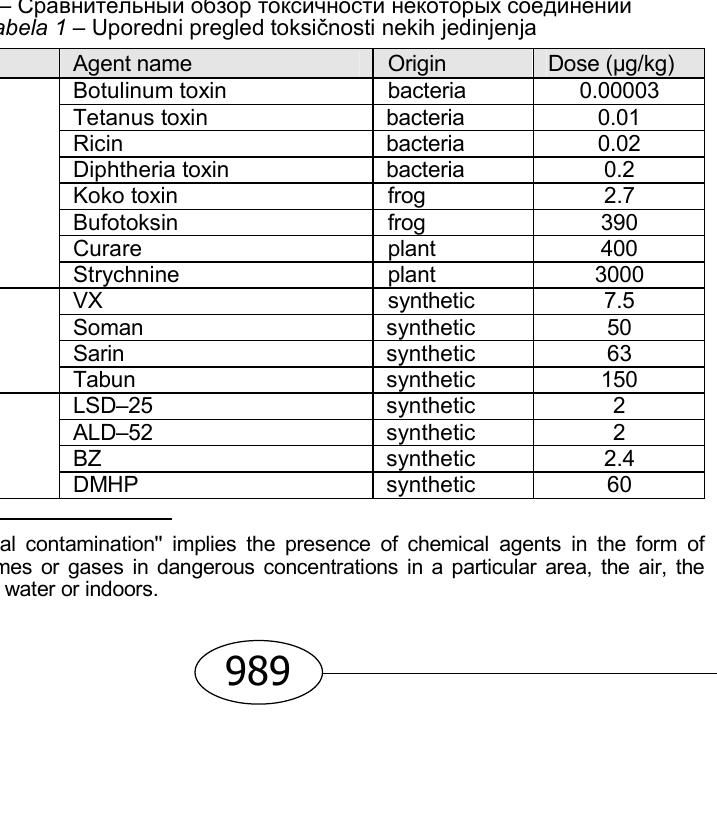
Table 1 – Comparative review of the toxicity of some agents Таблица 1 – Сравнительный обзор токсичности некоторых